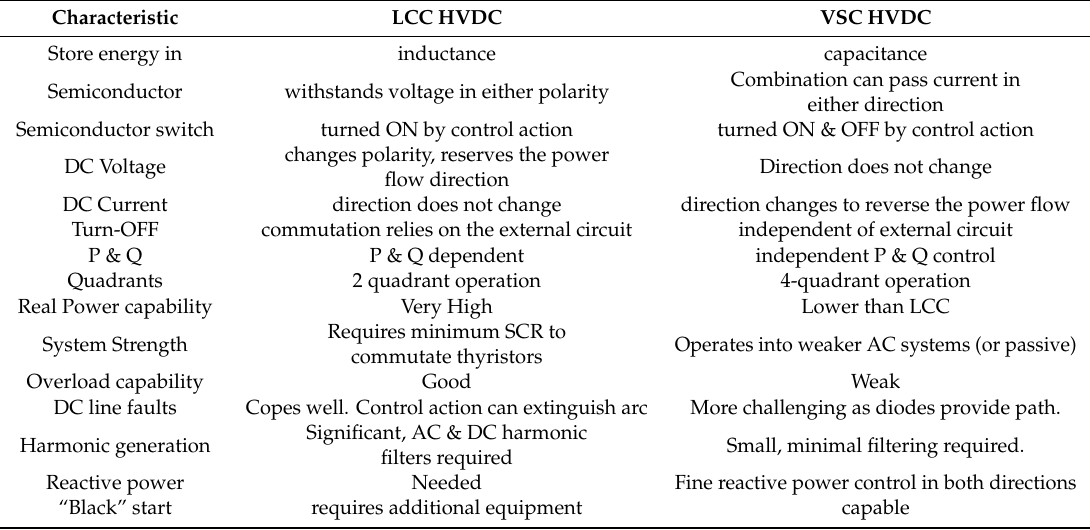
Table 1. Comparison of CSC based Line-Commutated Converter (LCC) and VSC HVDC systems. Characteristic